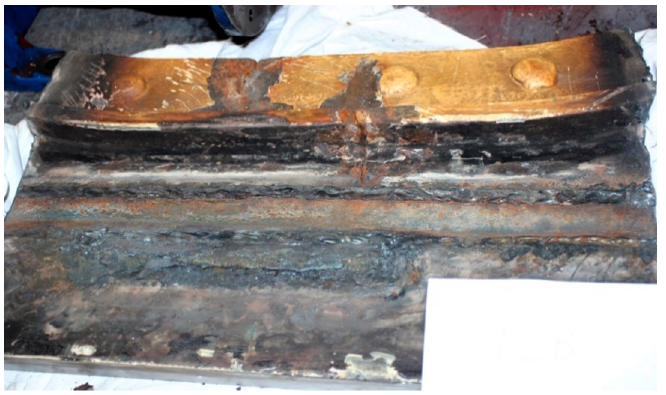
Figure 5. The insert and the welds that join the manhole structure and the deck (handy-size bulk carrier 30182 DWT). Macroscopic